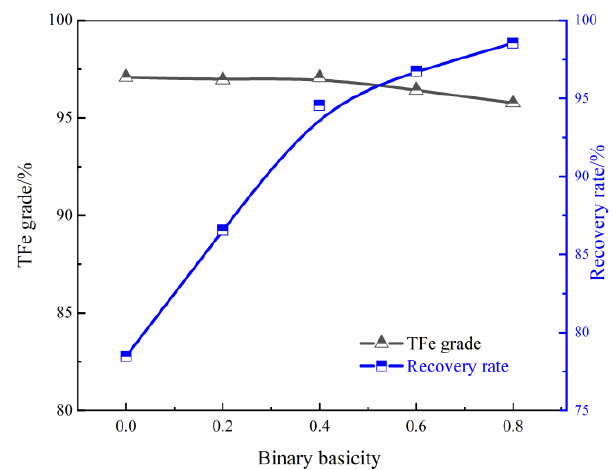
Figure 12. Effects of binary basicity (w(CaO)/w(SiO 2 )) levels on the smelting separation indices of the pre-reduced pellets. (Reducing at 1625 °C for 30 min and with 15% soft coal). (The yields of pig iron obtained at different binary basicity levels were 32.61%, 33.80%, 35.14%, 35.18%, and 34.20%, respectively).